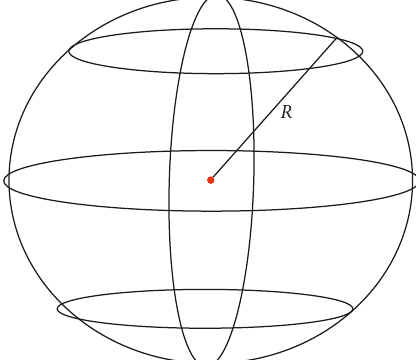
Figure 6: Spheroid burst ground stress dynamic